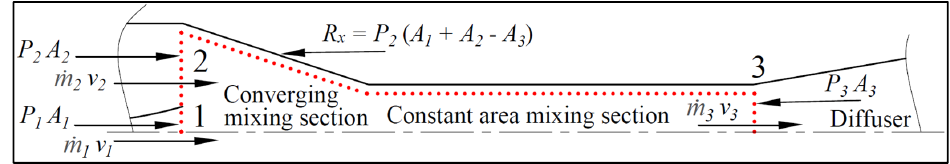
Figure 13. Forces and momentum flow on control volume C.